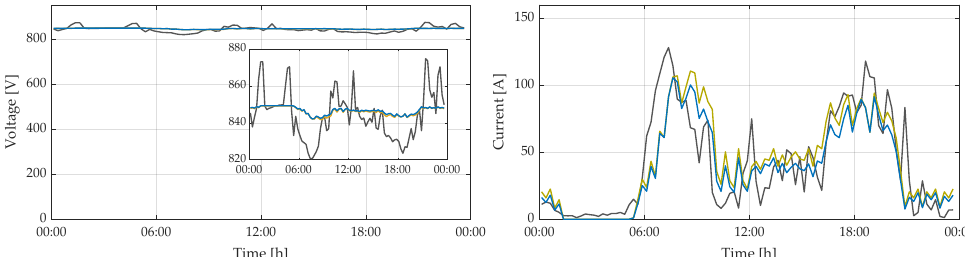
Figure 21. Voltage ( left ) and current ( right ) in TS T-T in an average window of 15 min. Measurements (black), simulation results with gross weight (yellow), and results of the weight-based simulation (blue). The plots cover a 24-h simulation scenario.